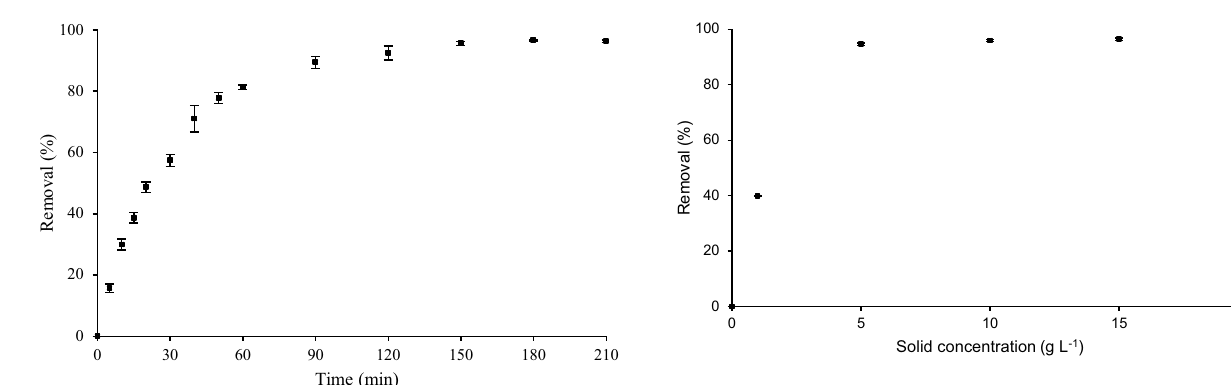
Fig. 3 Effect of adsorption time on PAR removal